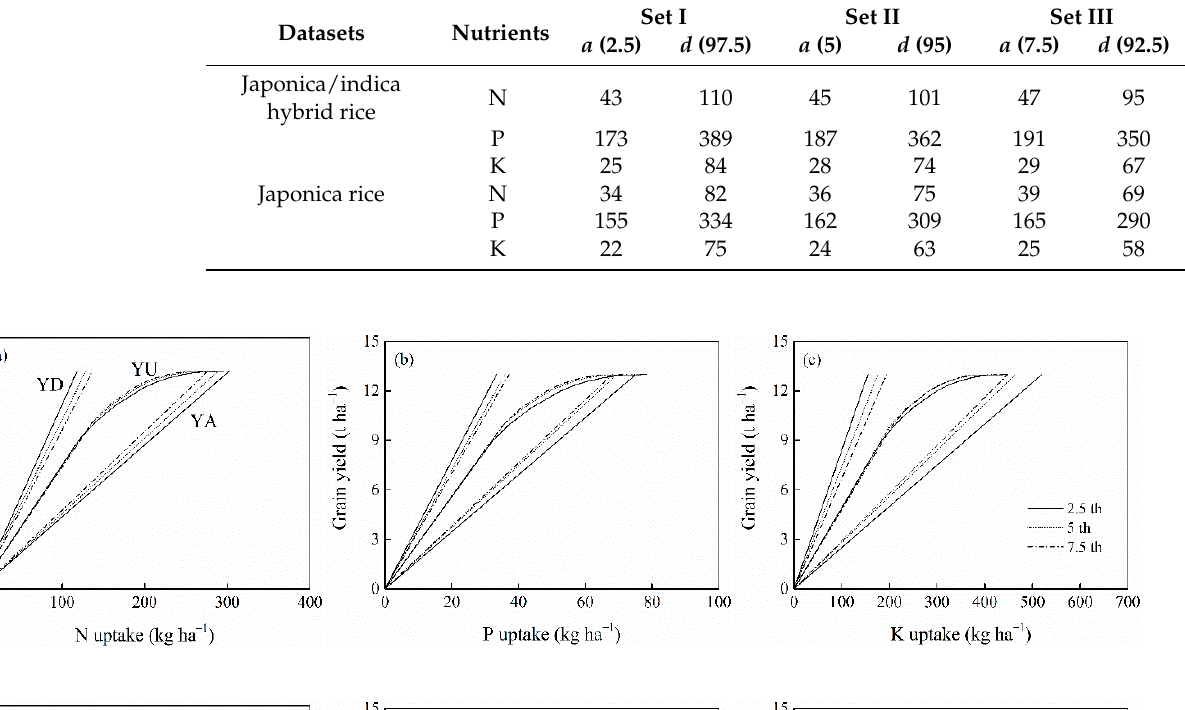
Table 3. Envelope coefficients of the maximum accumulation ( a ) and maximum dilution ( d ) of N, P,